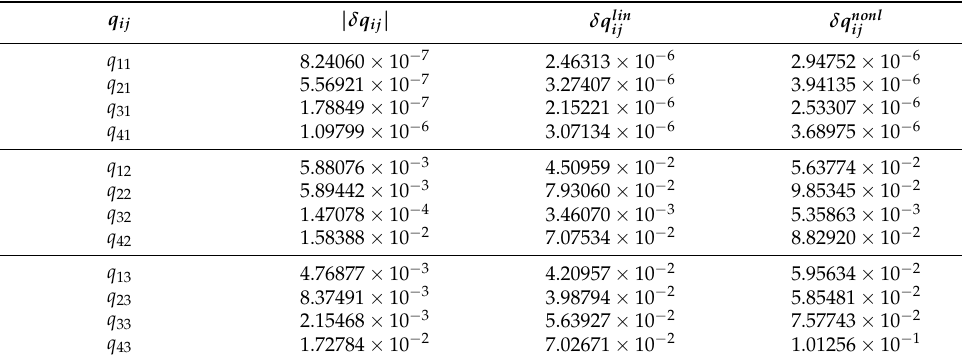
Table 3. Exact perturbations of the elements of the matrix Q 1 and their linear and nonlinear estimates, δ A = 3 × 10 − 6 A 0 , (cid:107) δ A (cid:107) F = 5.34977 × 10 − 5 , B ( δ Q lin ) = c Q (cid:107) δ A (cid:107) F = 0.13003, and B ( δ Q nonl ) = 0.14519. q